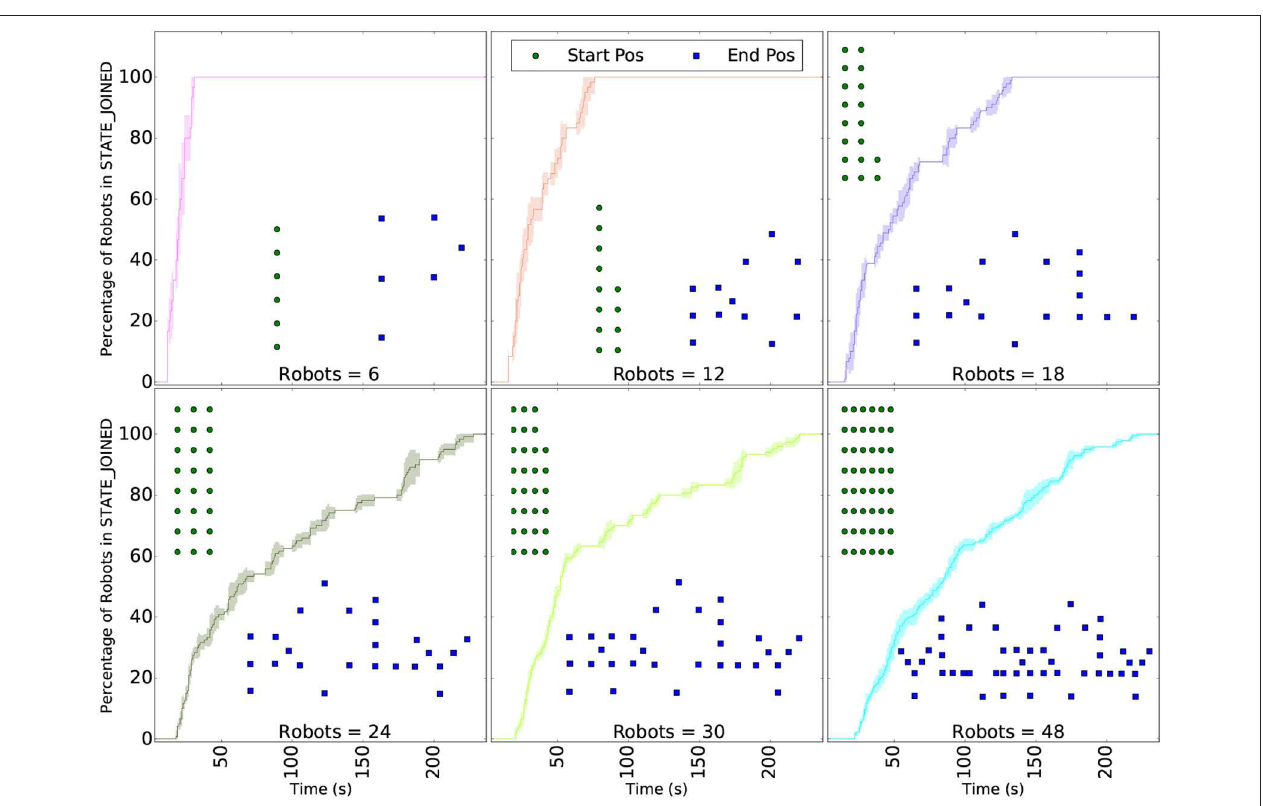
FIGURE 7 | Scalability of the task allocation algorithm presented in section 3.1.1. The curves show the percentage of robots in the last state of the algorithm: JOINED. Each scenario (packet drop rate) was ran 5 times and the variability of the results are shown in the area around the curves. The green dots illustrate the launch position of the robots and the blue dots, their final position. All simulations were ran without packet lost. The algorithm converges even with 48 simulated robots.